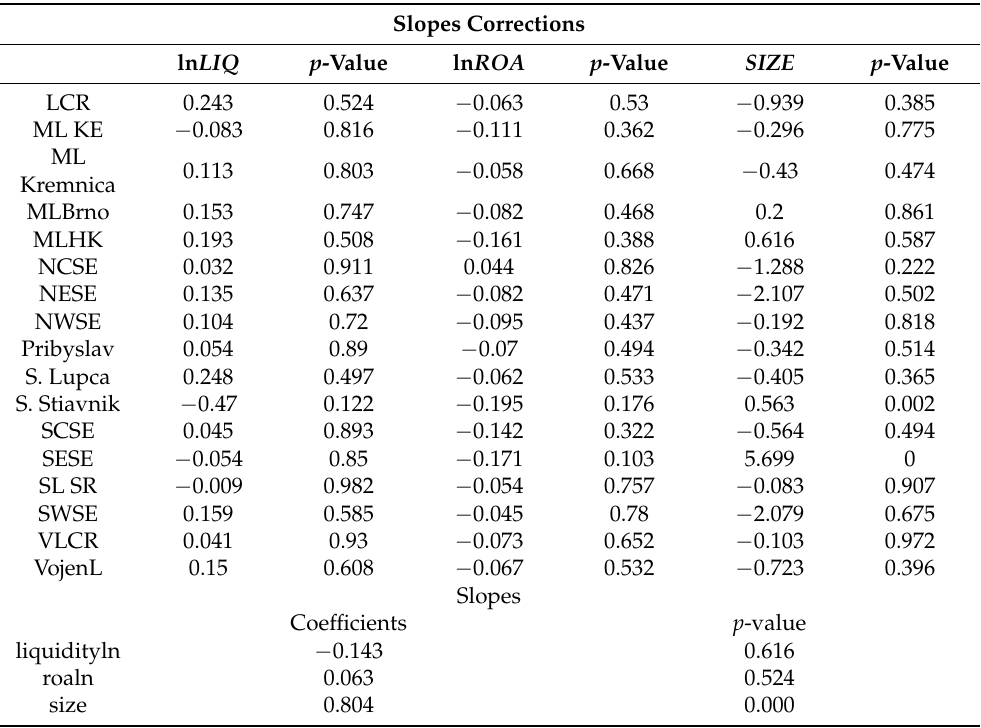
Table 7. Panel data results for model (2) with enterprise-difference-based slope corrections: α = 0.05; R = 0.998.